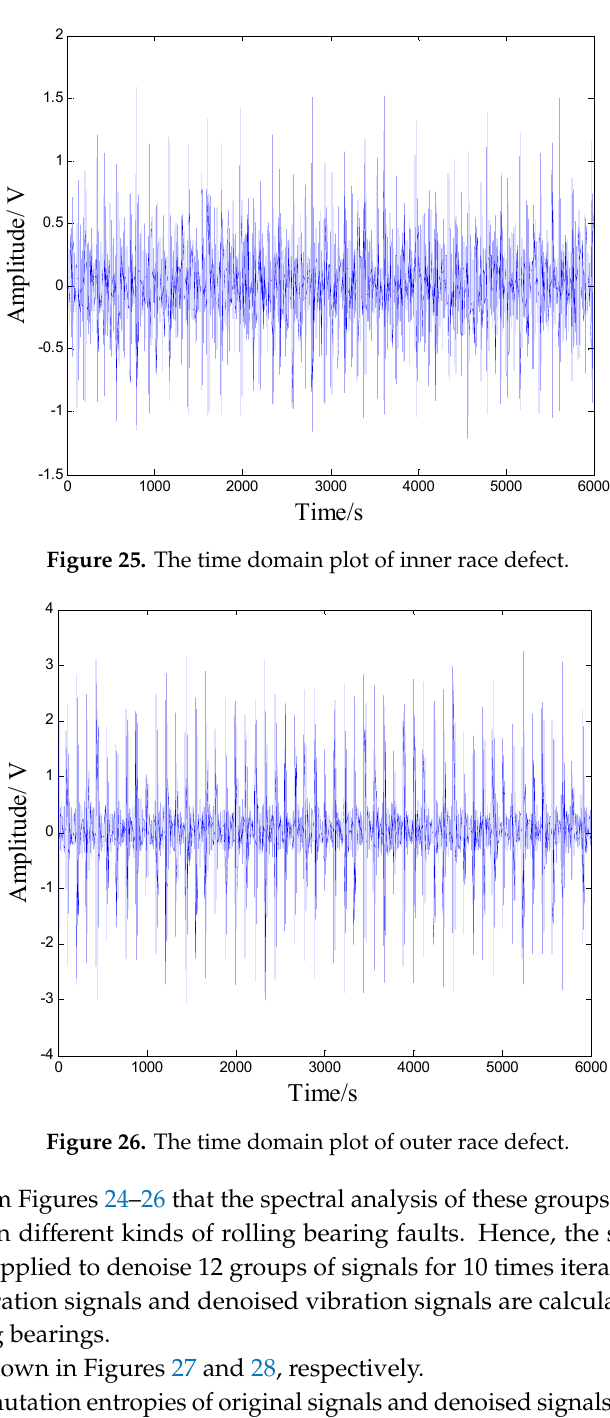
Figure 24. The time domain plot of ball defect.